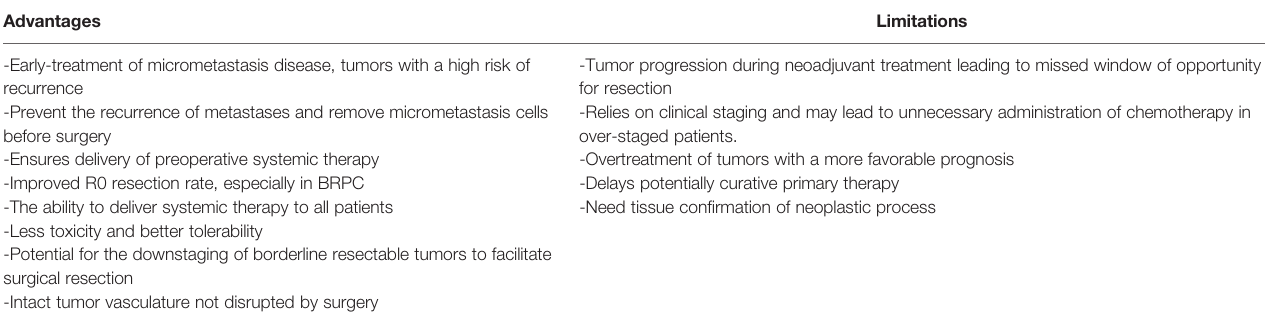
TABLE 4 | The advantages and limitations of